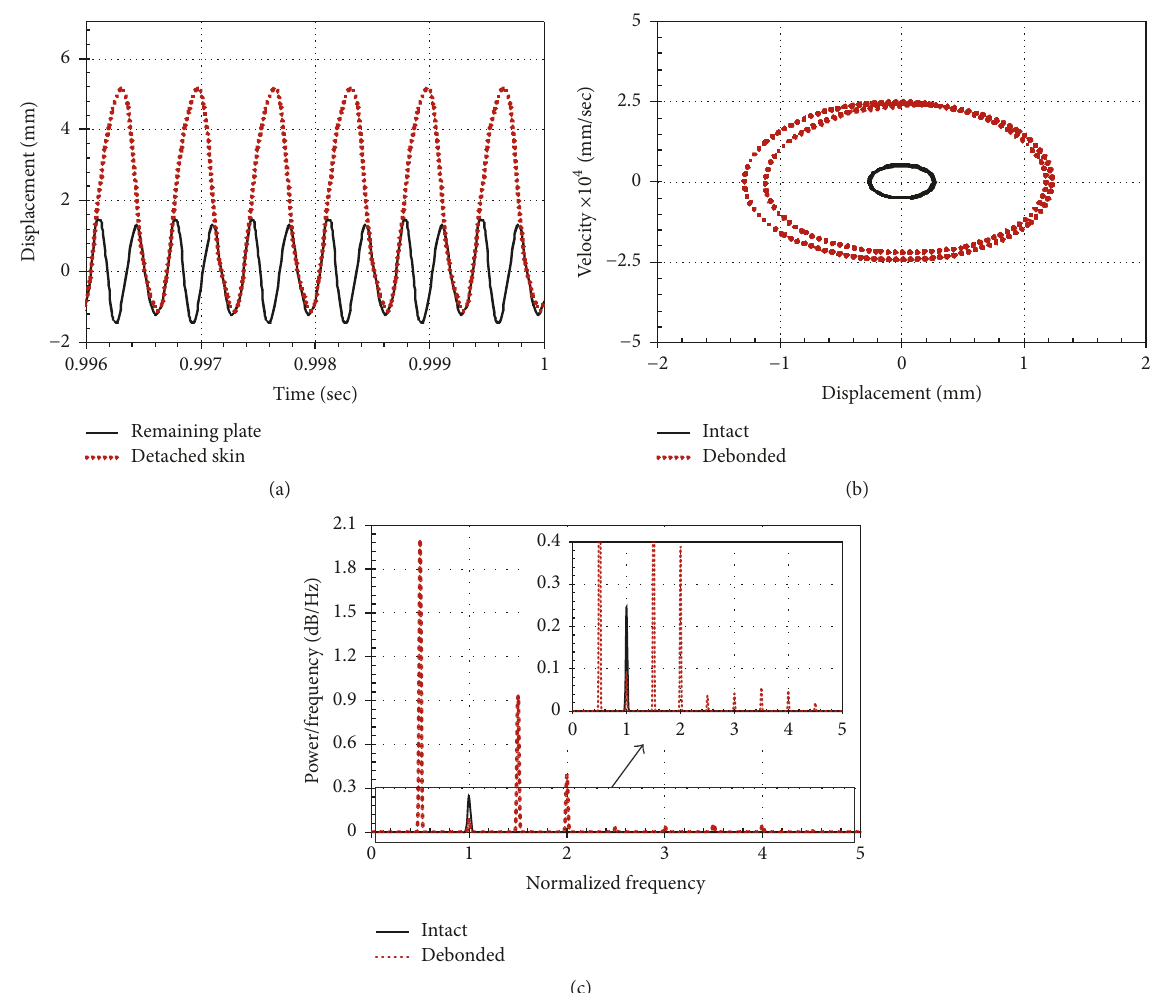
Figure 25: Steady-state dynamic response at 𝜂 = 3(Ω = 3000 Hz ) : (a) displacement time histories at points N2 and N3 [80]; (b) phase portrait at point N1; and (c) frequency spectra of the displacement signals at point